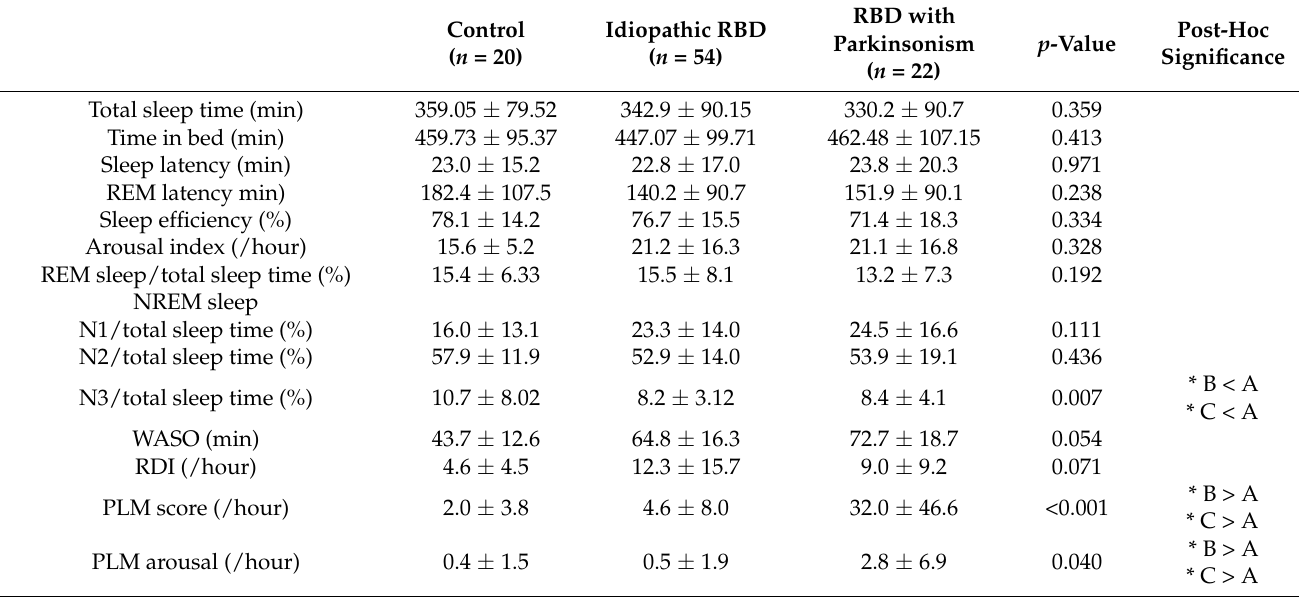
Table 2. PSG findings in controls, patients with idiopathic RBD, and patients with combined RBD and